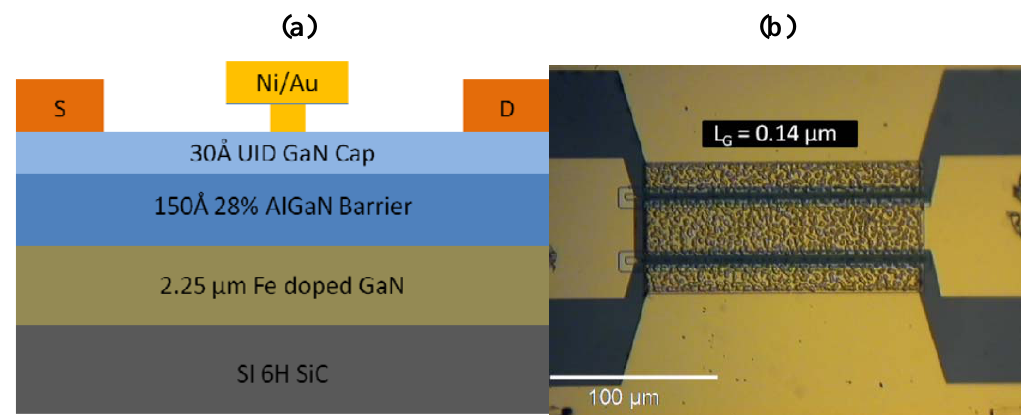
Figure 4. ( a ) Cross-section diagram of AlGaN/GaN HEMT; ( b ) Optical microscope image